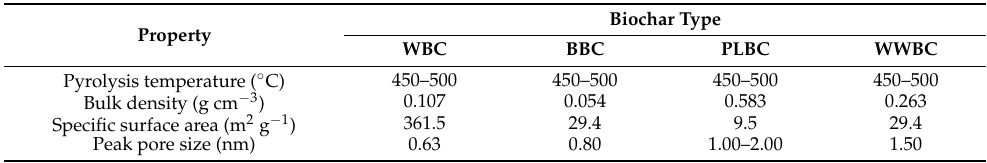
Table 1. Properties of the biochar samples produced from woodchips (WBC), bagasse (BBC), pel- letized poultry litter (PLBC) and waterweed Ludwigia grandiflora